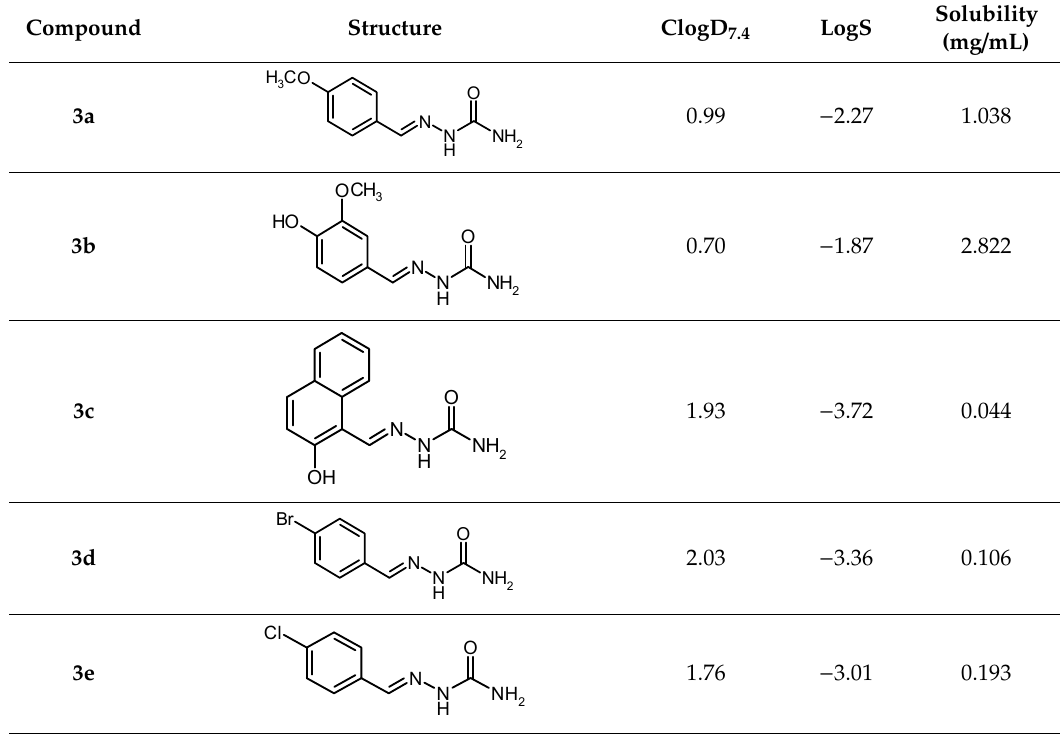
Table 2. Physicochemical parameters of compounds 3a-m and 4a : ClogD 7.4 and aqueous solubility. Compound Structure ClogD 7.4